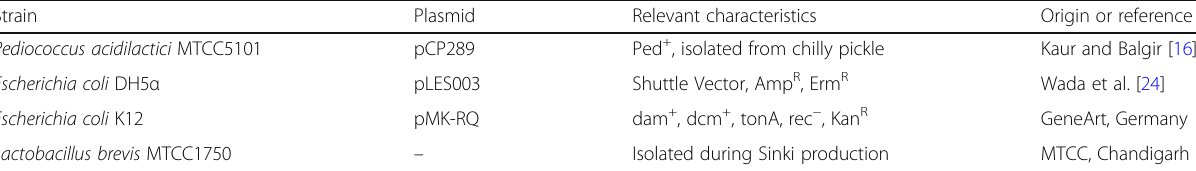
Table 1 Bacterial strains and plasmids used in the study Strain